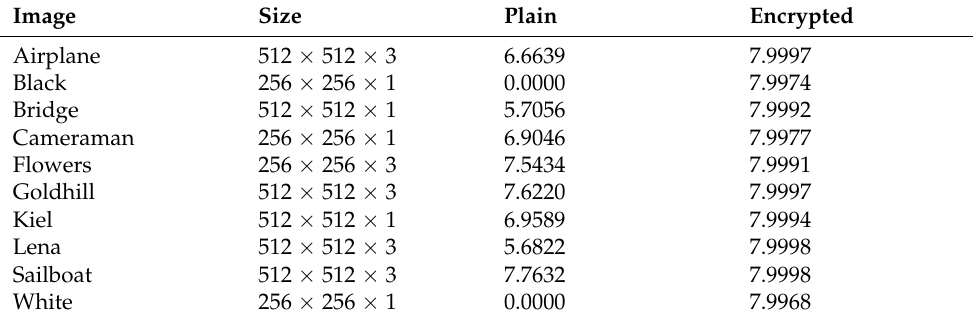
Table 9. Entropy test